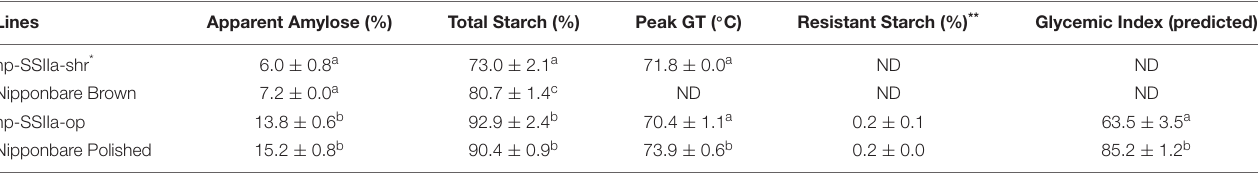
TABLE 1 | Functional properties of hp-SSIIa lines compared with the controls.